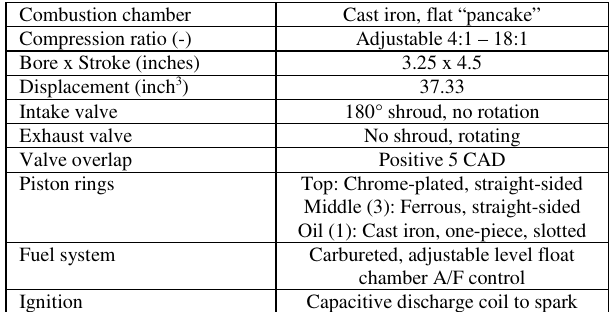
Table 2. Waukesha CFR F1/F2 engine geometry